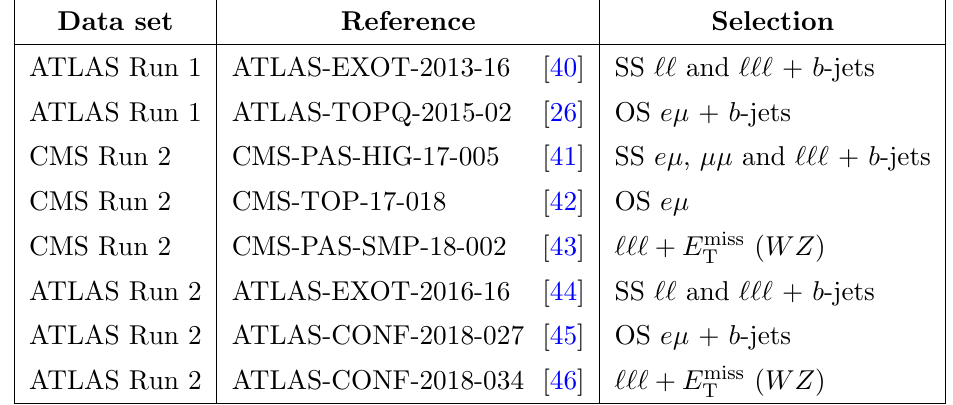
Table 1 . A list of the ATLAS and CMS experimental results pertaining to (cid:12)nal states with multiple leptons that are considered in this article. For each result, a simple baseline selection is shown. The di(cid:11)erent kinematic cuts and categories are not shown here, but are described for each analysis